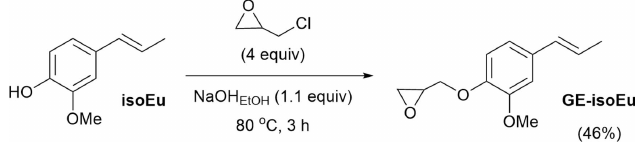
Figure 4 Synthesis protocol and reaction conditions leading to GE-isoEu